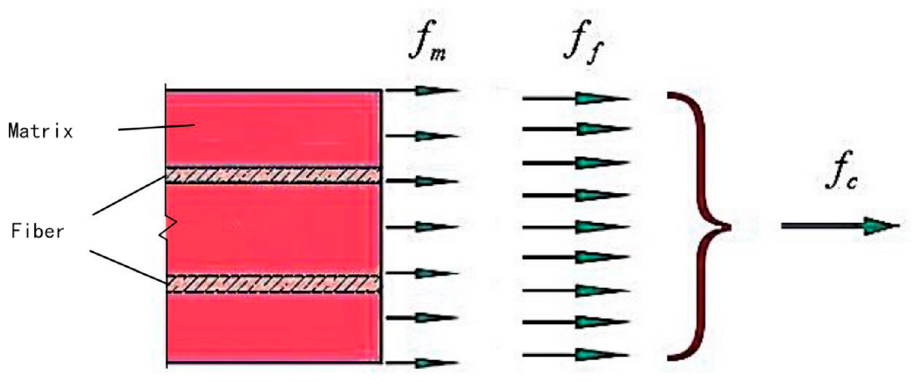
Figure 4. Mechanical reinforcement mechanism of steel fiber composite